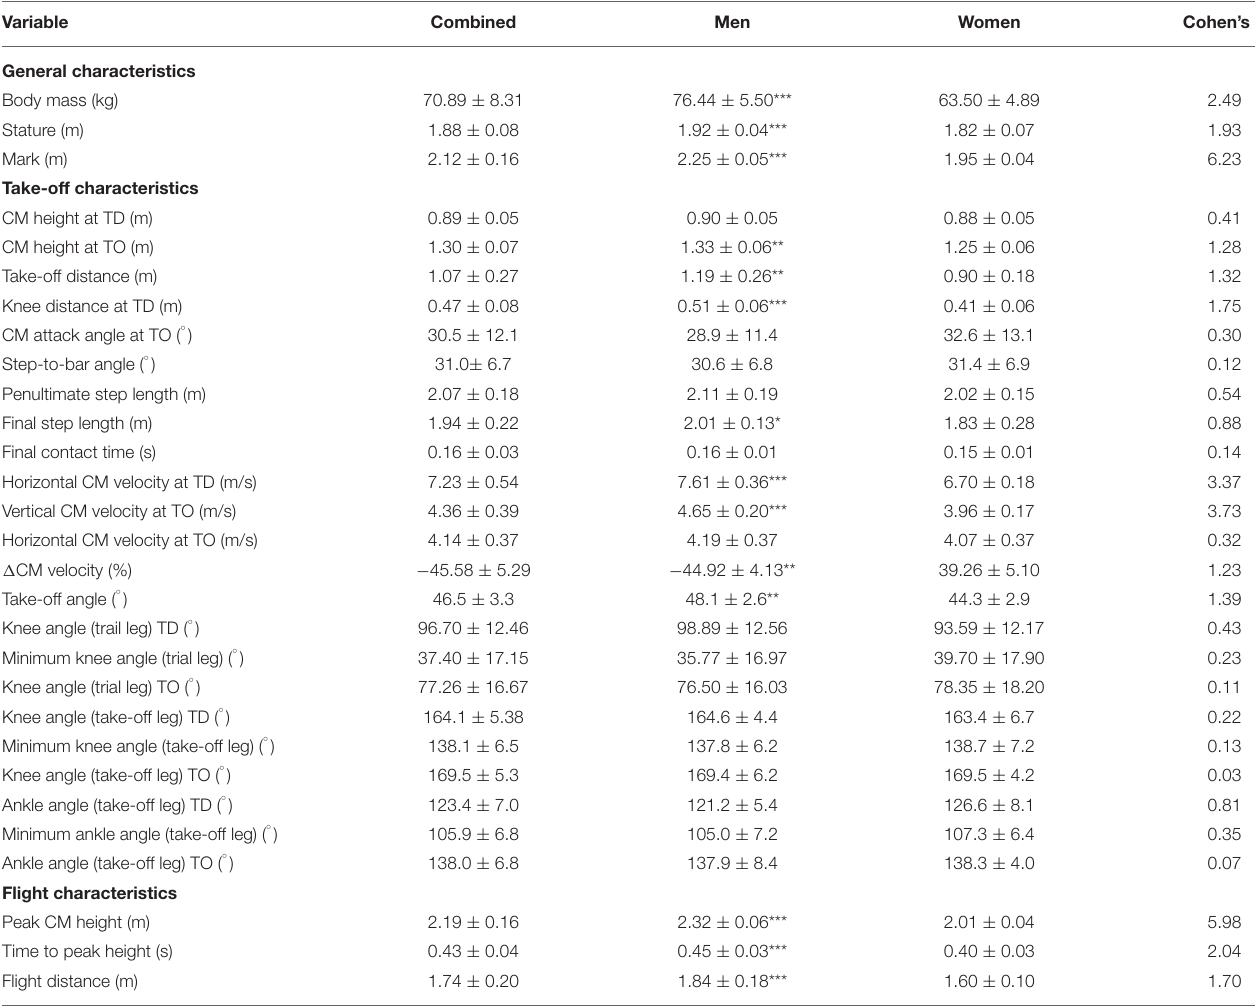
TABLE 3 | Variables (mean ± SD) representing the kinematic and temporal characteristics of the take-off and flight phases of the jumps for the men, women and combined sample.